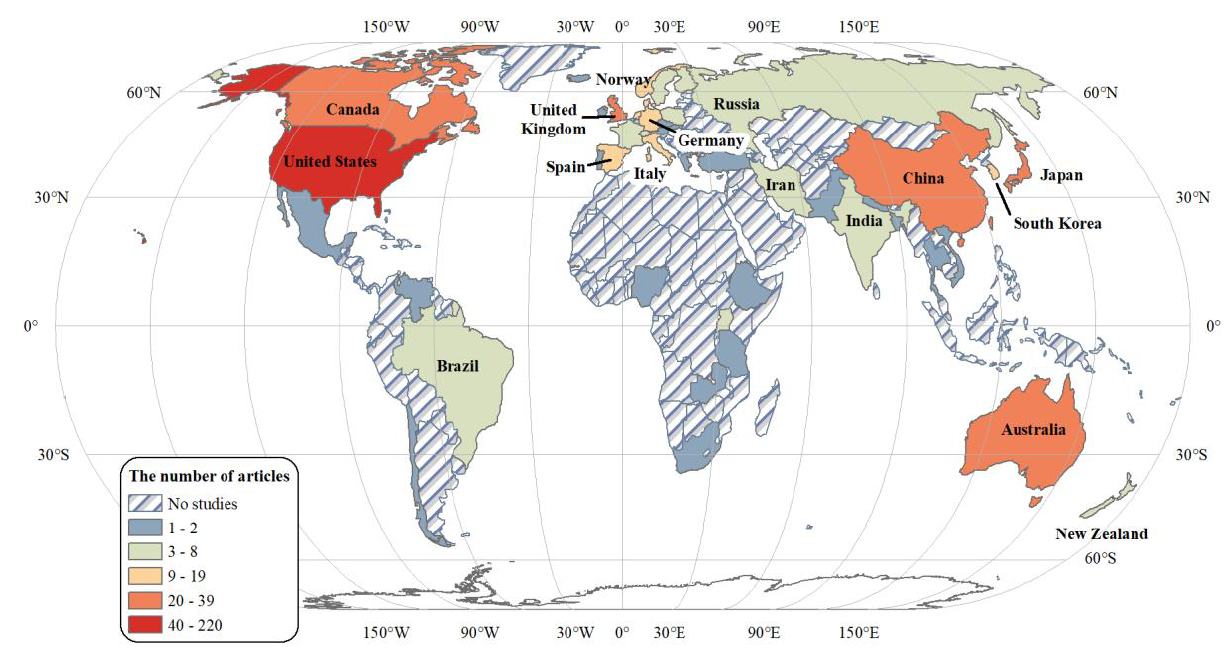
Figure 3. The global distribution of research on ALAN’s effects on human health.